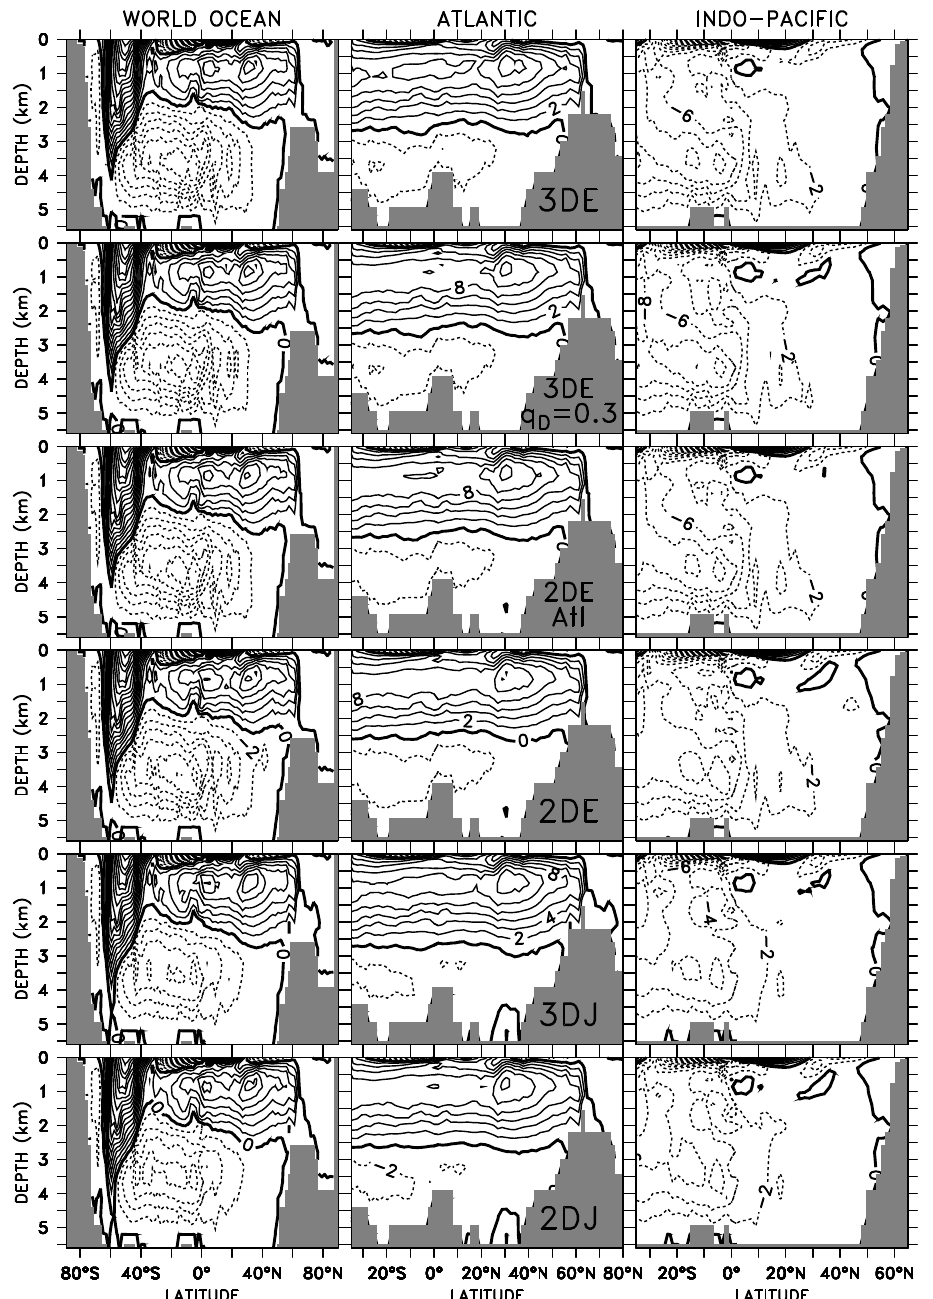
Fig. 6. Meridional overturning stream function in Sverdrups (1Sv=10 6 m 3 s − 1 ) at equilibrium (model year 4000) for the global (left), the Atlantic (center), and the Indo-Pacific (right) for experiments (from top to bottom) 3DE, 3DE q D = 0 . 3, 2DE Atl, 2DE, 3DJ, and 2DJ. Isolines are shown every 2Sv with positive (negative, dashed) values indicating clockwise (counter-clockwise) flow. The effect of complete local dissipation of tidal energy for the diurnal tides (3DE vs. 3DE q D = 0 . 3) is small. The largest effect is simulated for the AMOC, which increases by 0.8